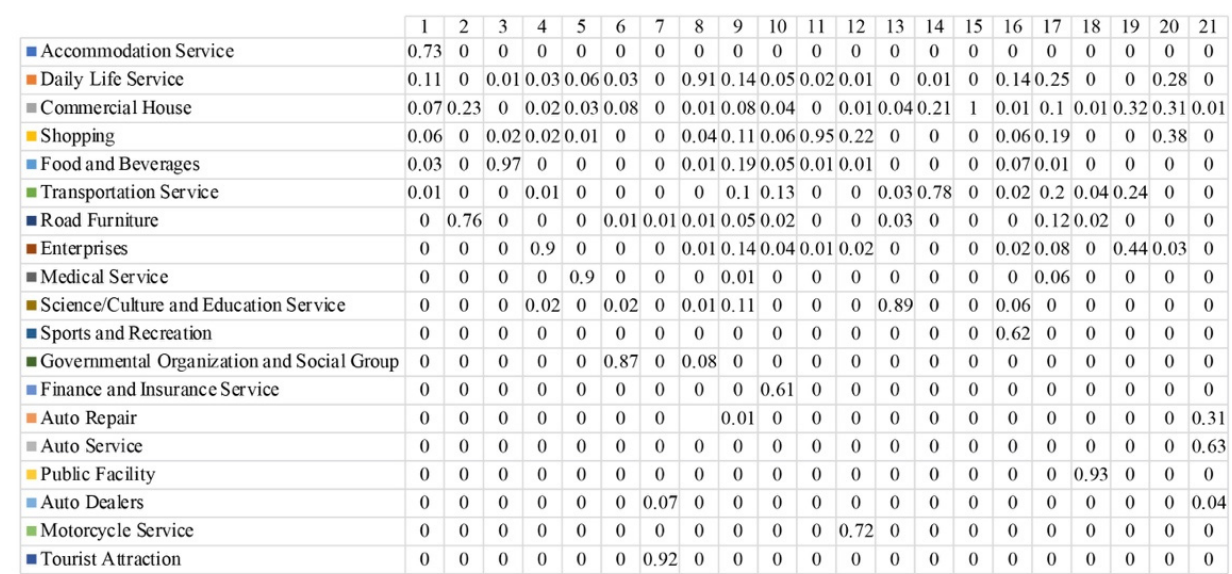
Figure 10. Twenty-one topics and the word probability in each